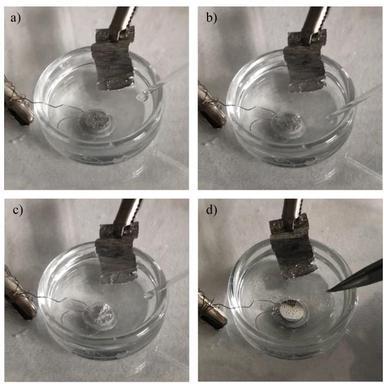
Photographs of the delamination step of the transfer process, showing gradual formation of bubbles and subsequent delamination of PMMA/MoS2/ graphene from Ir (111). Photographs are taken every 60 s a) – d) subsequently.